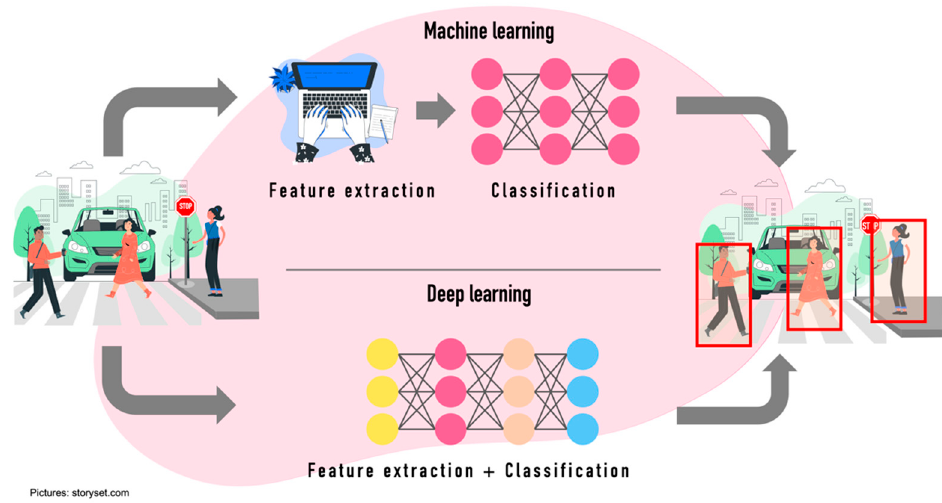
Figure 7. Representation of the difference between ML and DL. Based on [87].